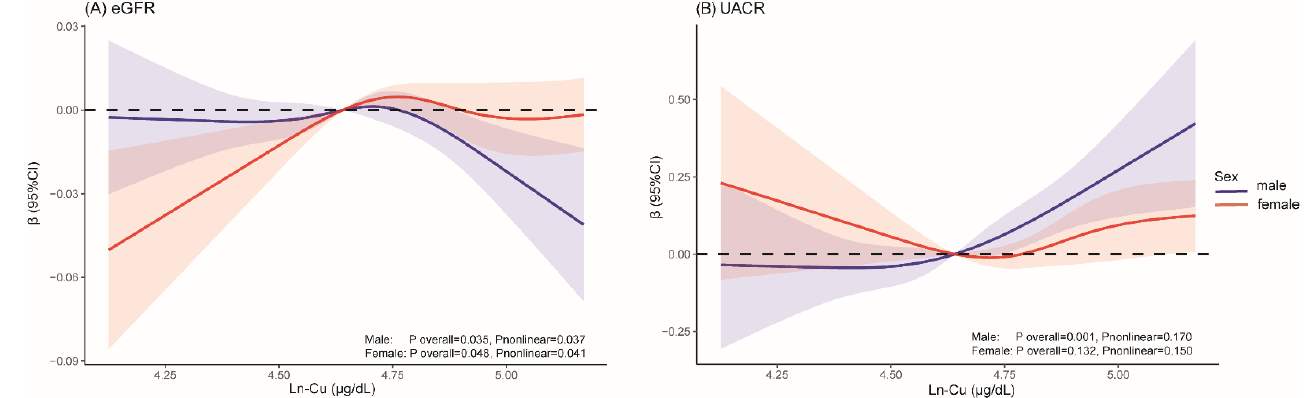
Figure 2. Sex-specific restricted cubic spline (RCS) analysis of dose–response relationship between serum Cu levels and kidney function. ( A ) eGFR; ( B ) UACR. The lines with shading represent adjusted β [95% confidence interval (CI)] based on RCS. Models adjusted for age, race, BMI, educational attainment, PIR, alcohol drinking, smoking status, hypertension, and diabetes.